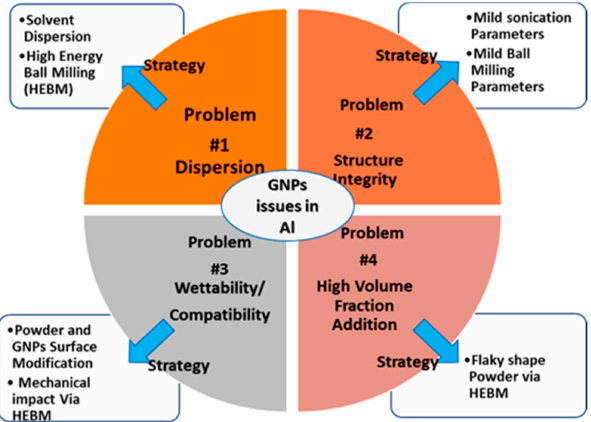
Figure 1. Critical issues associated with GNPs incorporation in Al matrix exist and their related strategy adopted in present